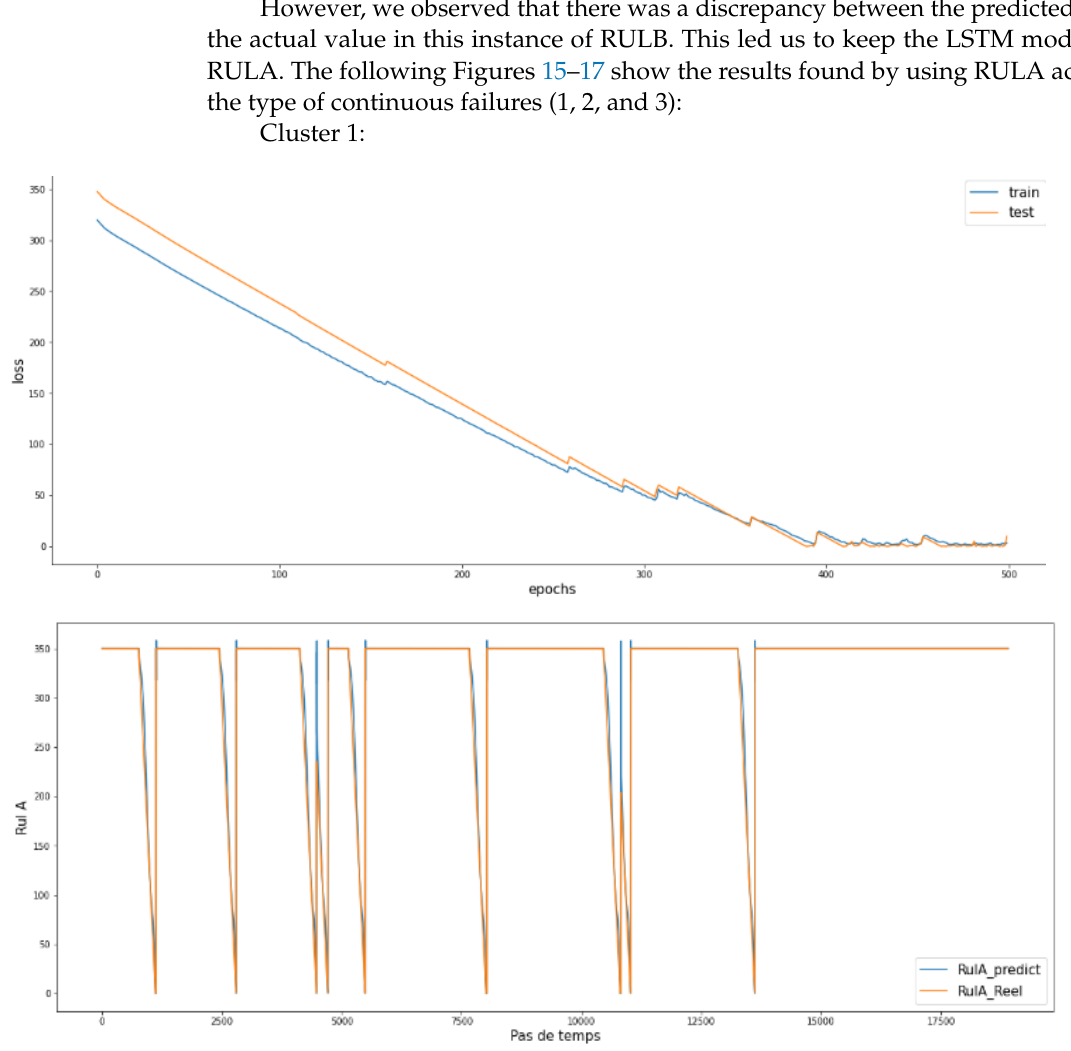
Figure 14. ( a ) LSTM method for discrete-RULB cluster 2;( b ) LSTM Method for discrete-RULB cluster 1.